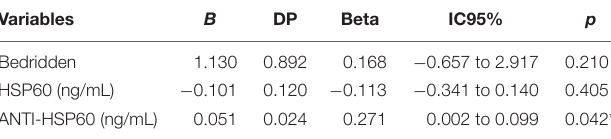
TABLE 3 | Relationship of risk factors in Framingham